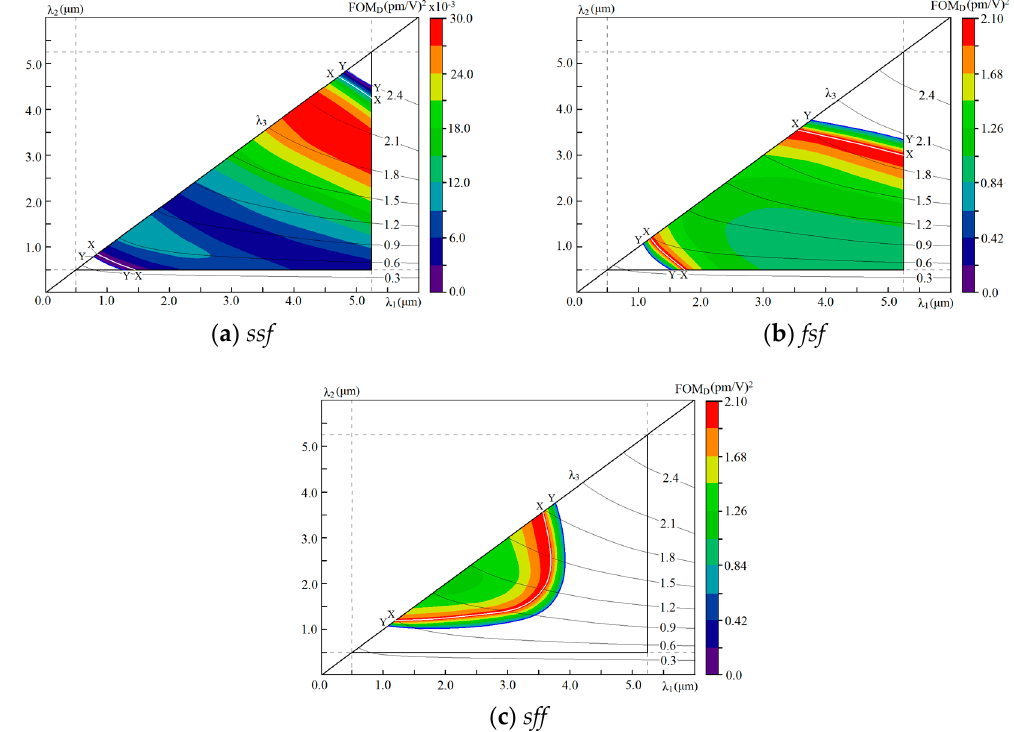
Figure 8. FOM D ( λ 1 , λ 2 ) distributions for KTA crystal for all types of interactions: ( a ) ssf , ( b ) fsf , ( c ) sff.